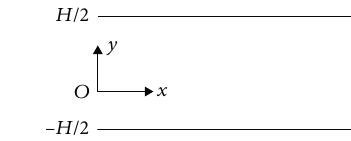
Figure 3: Poiseuille fl